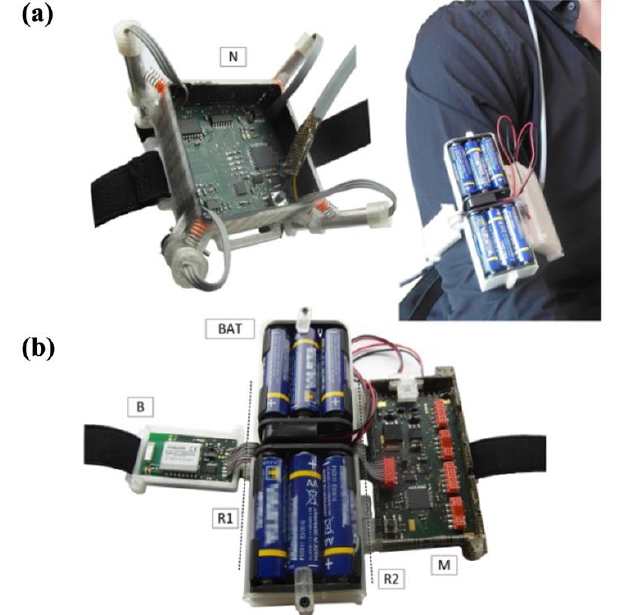
Figure 7. Complete system with ( a ) single 4 channel fNIRS module and ( b ) Bluetooth module. Reproduced from reference [59].